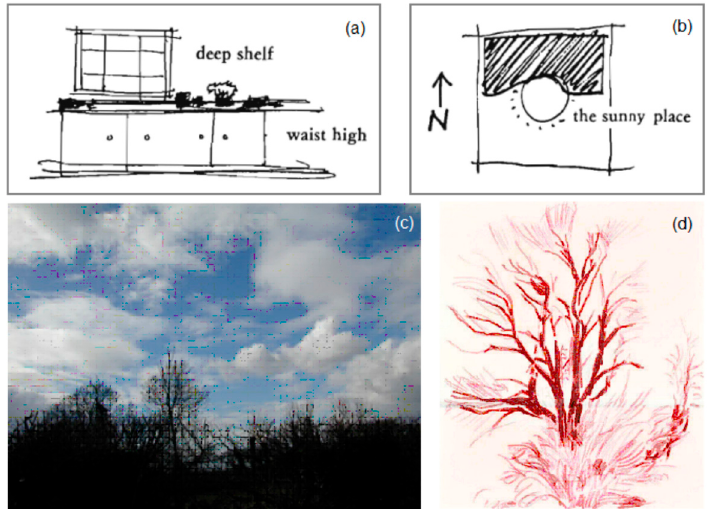
Figure 3. (Color online) Alexander’s miniscule observation on architecture and nature. Note: ( a ) A waist-high shelf, ( b ) a sunbeam coming into a room, ( c ) the interlocking blue sky and white clouds, and ( d ) positive space generated between a tree’s branches [2,24].